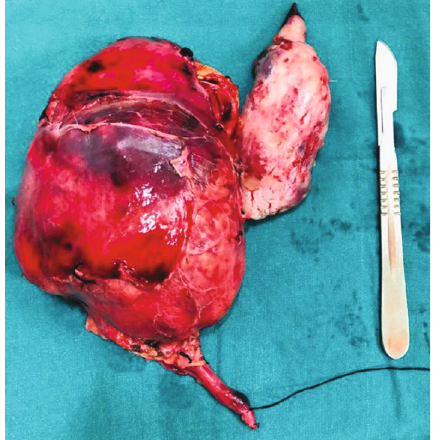
Figure 4: Specimen of the right kidney and IVC thrombus.